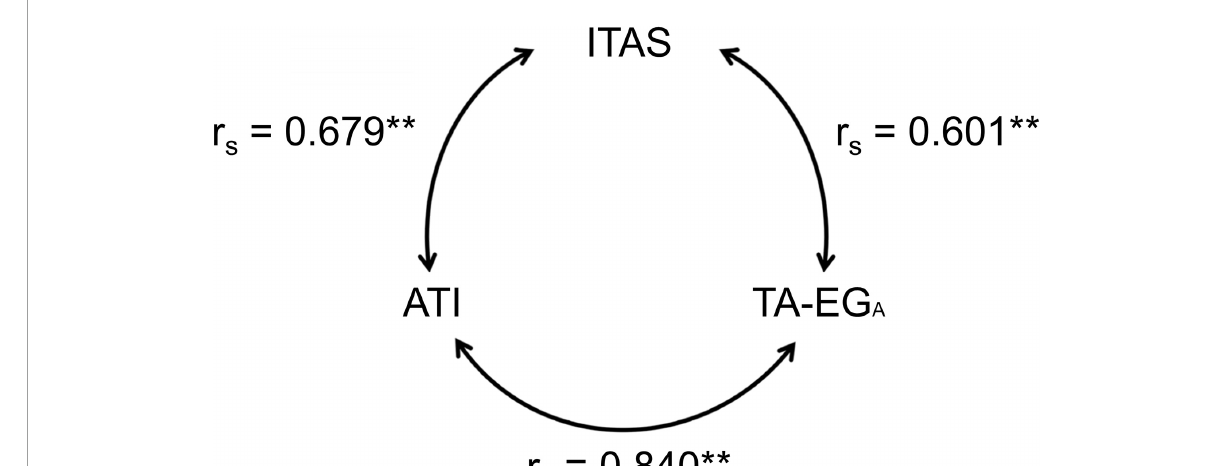
5.34% choose answer 7. Answer option 4 was chosen the most with 31.49%. With a mean value of 4.2, the standard deviation is 1.38. In summary, it can be stated that all response options of the instrument were used in sample